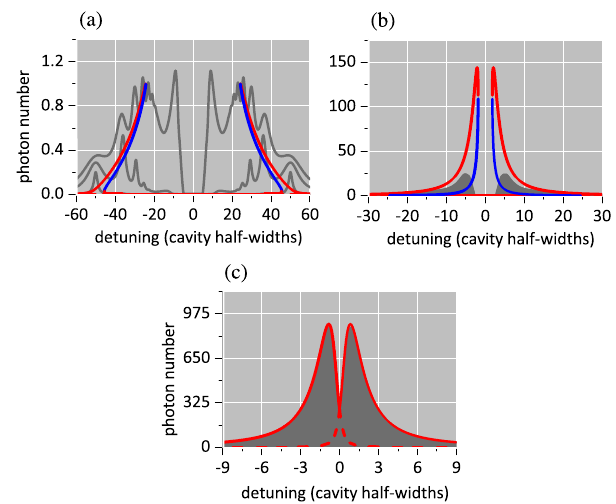
FIG. 4. Mean-field photon number j α j 2 (red and blue curves), compared with the photon-number mean, including quantum fluctuations (gray), for a dipole-coupling strength g= κ ¼ 50 and drive amplitudes (a) E = κ ¼ 1 (red and blue) and 1,5,8 (gray, lower to upper), (b) E = κ ¼ 12 , and (c) E = κ ¼ 30 . Steady states plotted as solid red (blue) curves are stable (unstable); those plotted as dashed red curves — running close to j α j 2 ¼ 0 in (a) and (b) — have ζ > 0 and are